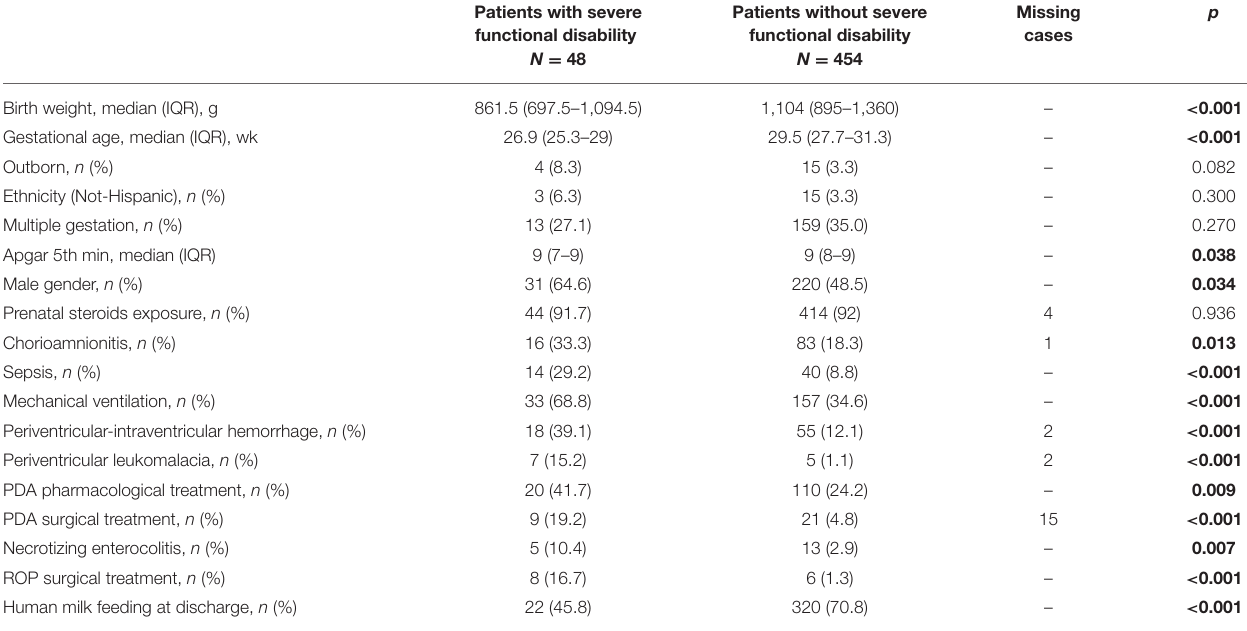
TABLE 3 | Neonatal characteristics of infants with or without severe functional disability at 24 months.